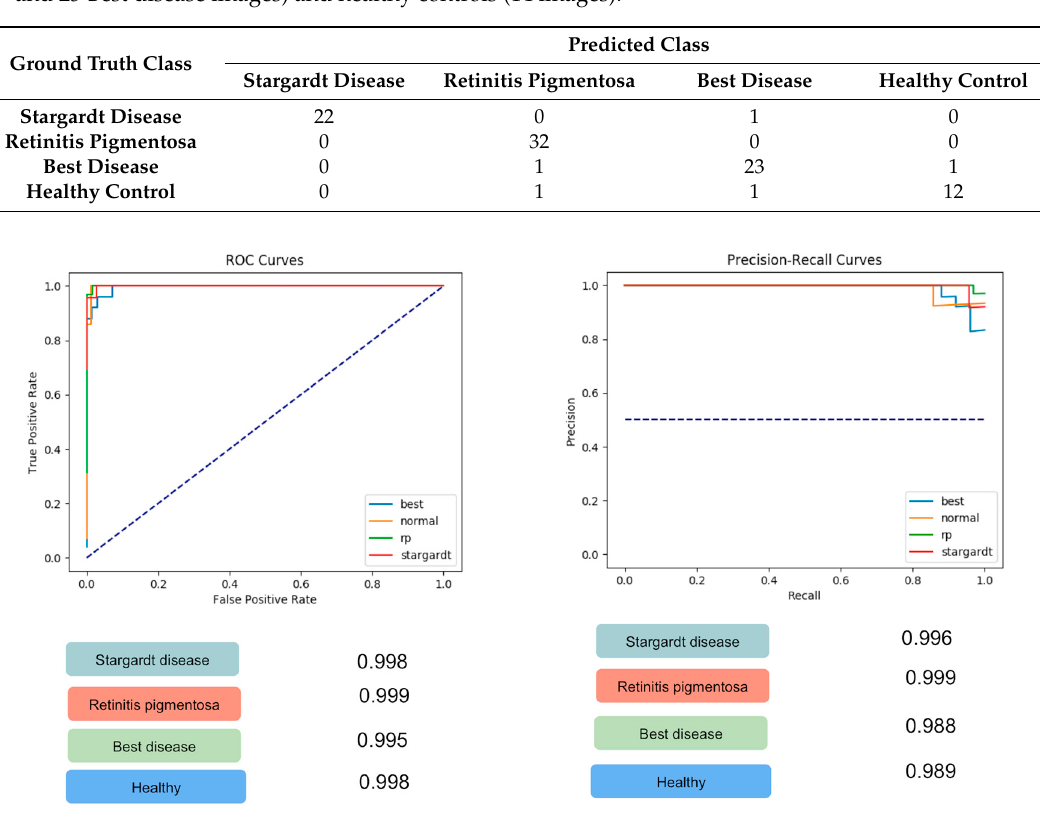
Figure 2. Receiver operating characteristics (ROC) and precision-recall (PRC) area under the curve (AUC) for the 4 classes: Stargardt disease (STGD), Retinitis pigmentosa (RP), Best vitelliform macular dystrophy (BD), and healthy controls. For STGD, the ROC-AUC (left panel) was 0.998 and the PRC-AUC (right panel) was 0.986. For RP, the ROC-AUC (left panel) was 0.999 and the PRC AUC (right panel) was 0.999. For BD, the ROC-AUC (left panel) was 0.995 and the PRC AUC (right panel) was 0.988. For healthy controls, the ROC-AUC (left panel) was 0.998 and the PRC-AUC (right panel) was 0.989.